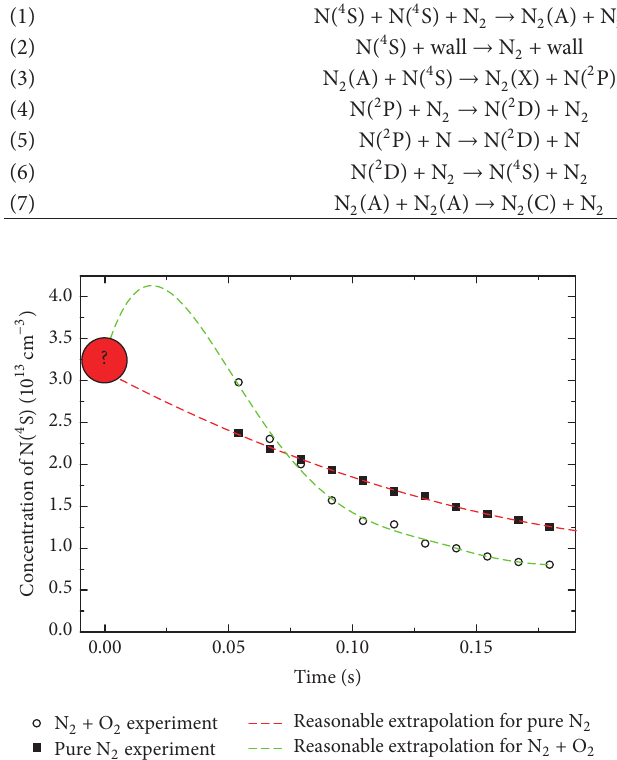
Figure 5: Data from the previous figure recalculated from distance to time. The rough estimation of initial [N] value at 𝑡 = 0 s is shown, too. The sketch of a reasonable time evolution is shown by dashed